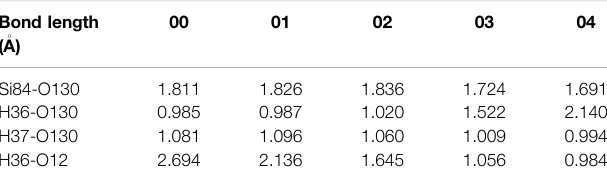
TABLE 6 | Changes in bond length for the reaction of H 2 O and P b1 defect with AOD con fi guration at random position